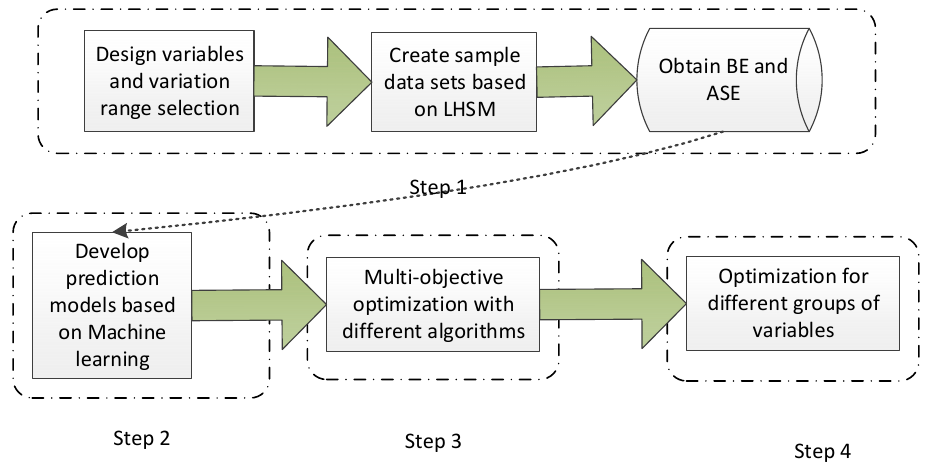
Figure 1. Optimal solution procedure (BE: building energy consumption; ASE: ASE area in range).